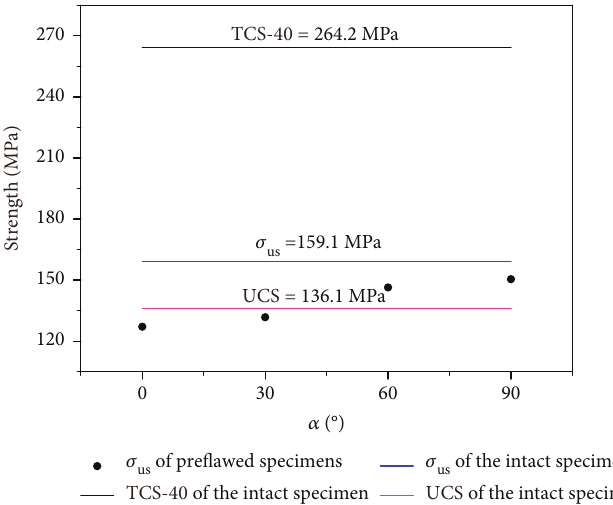
Figure 11: Comparisons of the unloading failure strength σ